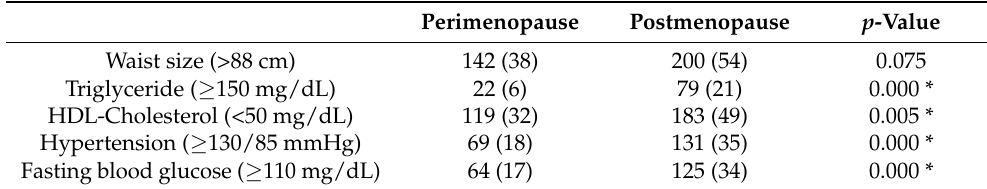
Table 3. Distribution of metabolic syndrome markers in peri- and post-menopausal women according to NCEP criteria.